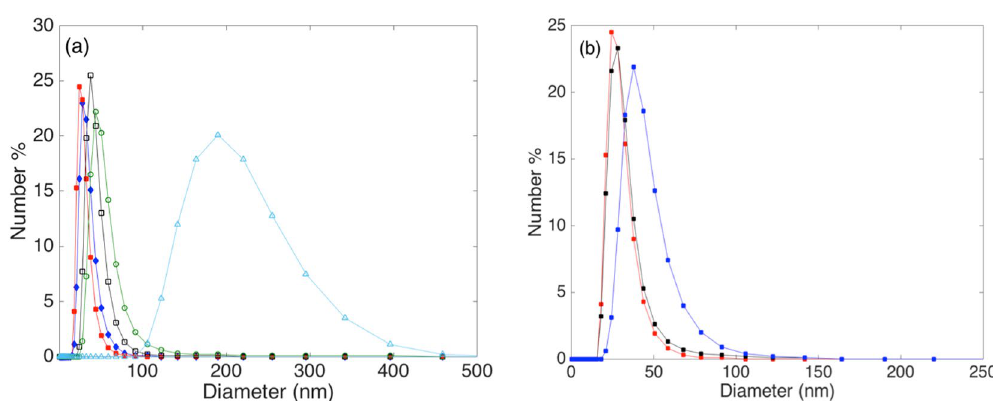
Figure 2. ( a ) Size distributions of MPPC liposomes containing 2 wt% ( ), 4 wt% ( ), 6 wt% ( ), 8 wt% ( ), 10 wt% ( ) SPION after formation. ( b ) Size distribution of MPPC with 4 wt% SPION immediately after formation (red), after 1 week (black) and 11 months after their formation